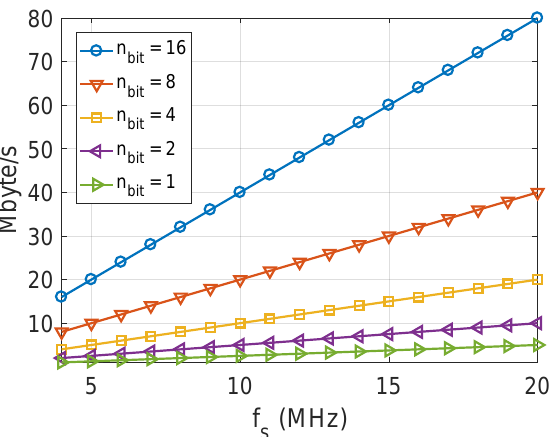
Figure 4. Memory requirement for a range of sampling frequencies and different quantization levels.